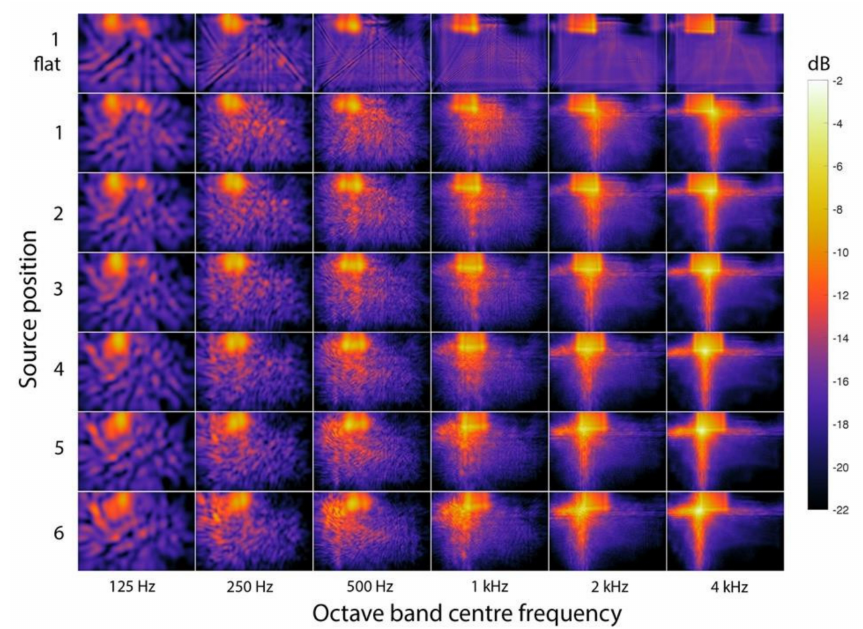
Figure 4. Spatial distribution of the octave-band reflected energy level for the Lahan Vav simulation over a horizontal plane of 18.8 m x 12.7 m for the six source positions. The source positions are evident from the maxima, especially in the 4 kHz band (the two towers are at the top of each subplot). Values are expressed relative to the emitted sound energy level at 1